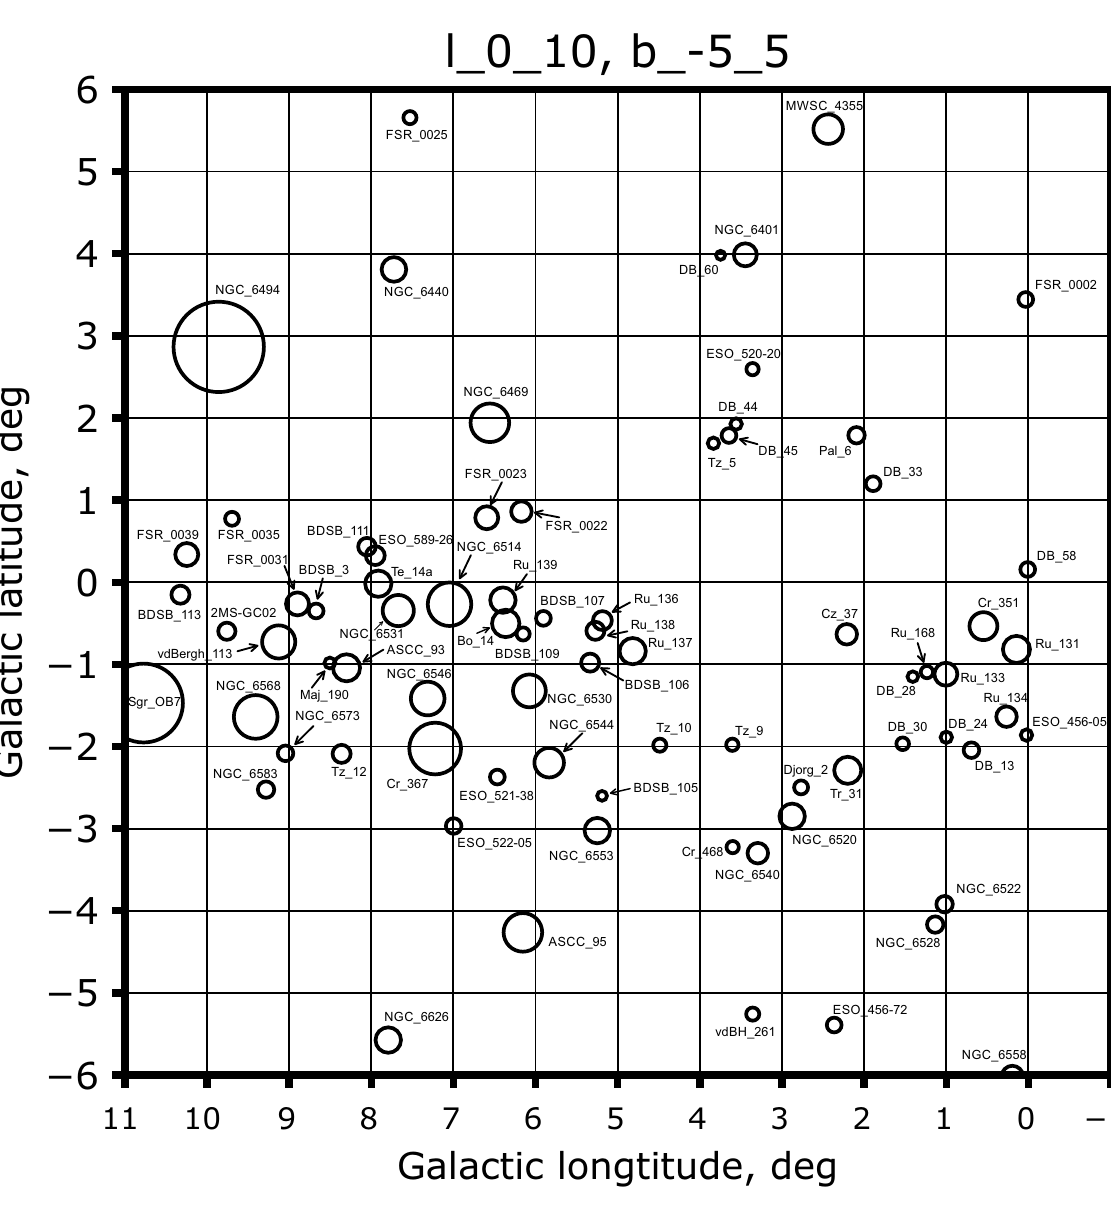
online atlas should indicate cluster names in accordance with this table. Some shortenings are commonly used, some of them have been adopted by authors of this pa- per. Other cluster names are the same as in the catalogue of Kharchenko et al. (2013). The user of the online atlas should realize that every cluster name contains the under- lined symbol between the proper name and the number (for example, NGC_7789; also see Table